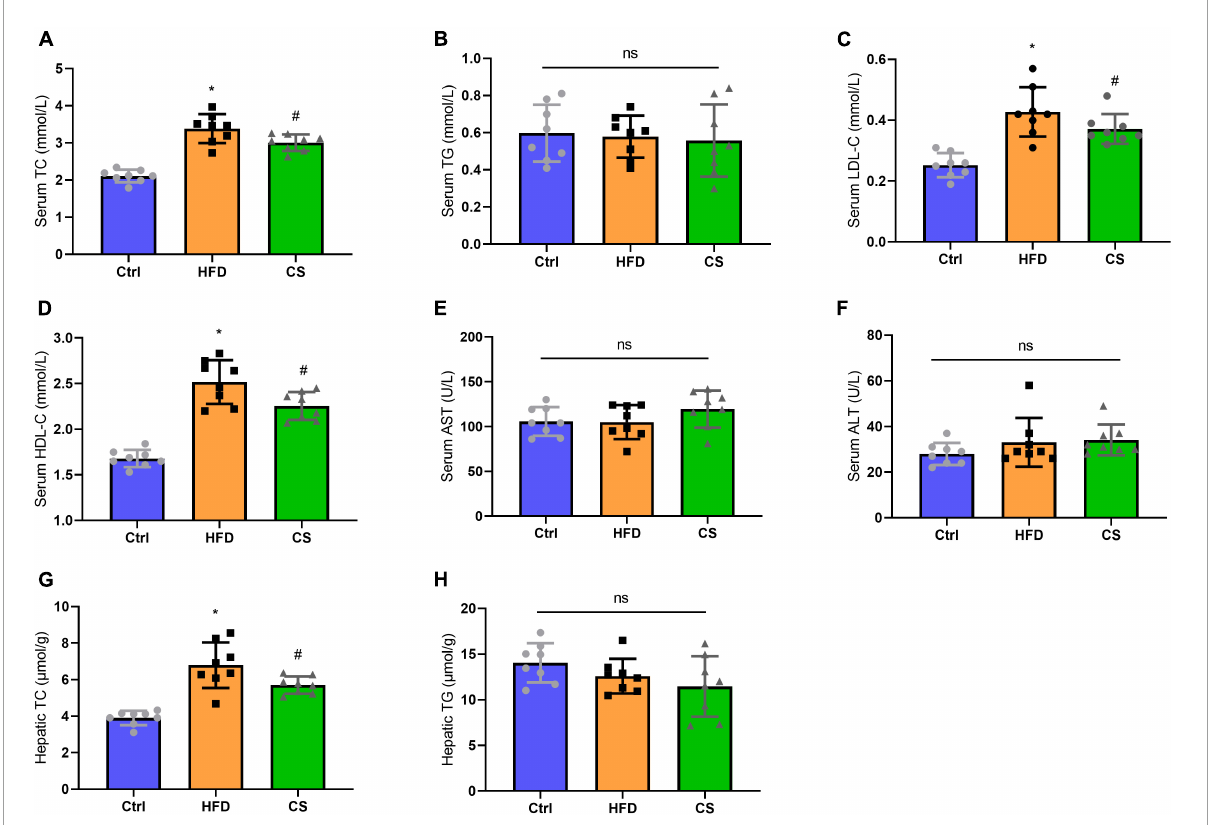
FIGURE4 Effect of corn silk extract on lipid contents of the serum and liver. (A) Serum TC; (B) serum TG; (C) serum LDL- C; (D) serum HDL-C; (E) serum AST; (F) serum ALT; (G) hepatic TC; (H) hepatic TG. Control diet (Ctrl) group, high- fat diet (HFD) group, corn silk (CS) group. The results are means ± SD ( n = 8). * p < 0.05 vs. Ctrl, # p < 0.05 vs. HFD. ns, not significant.